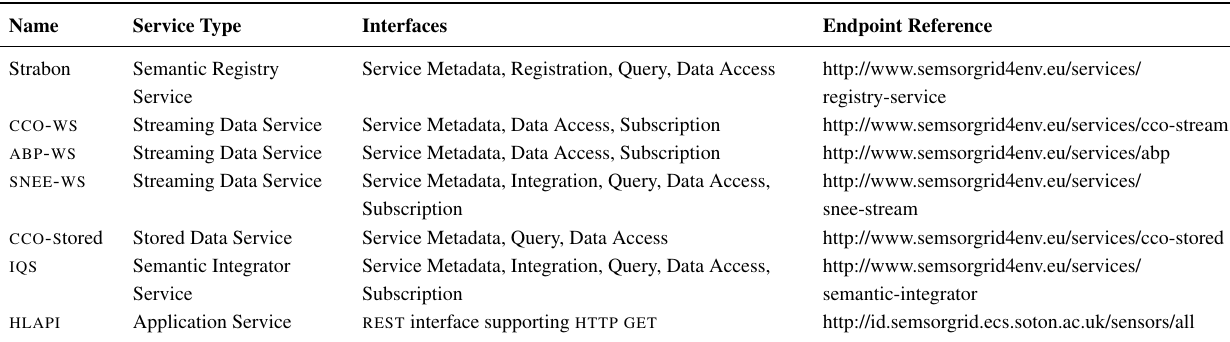
Table 2. Details of the deployed semantic sensor web services: the service name, the type of service, the interfaces supported, and the endpoint reference. The full list of active